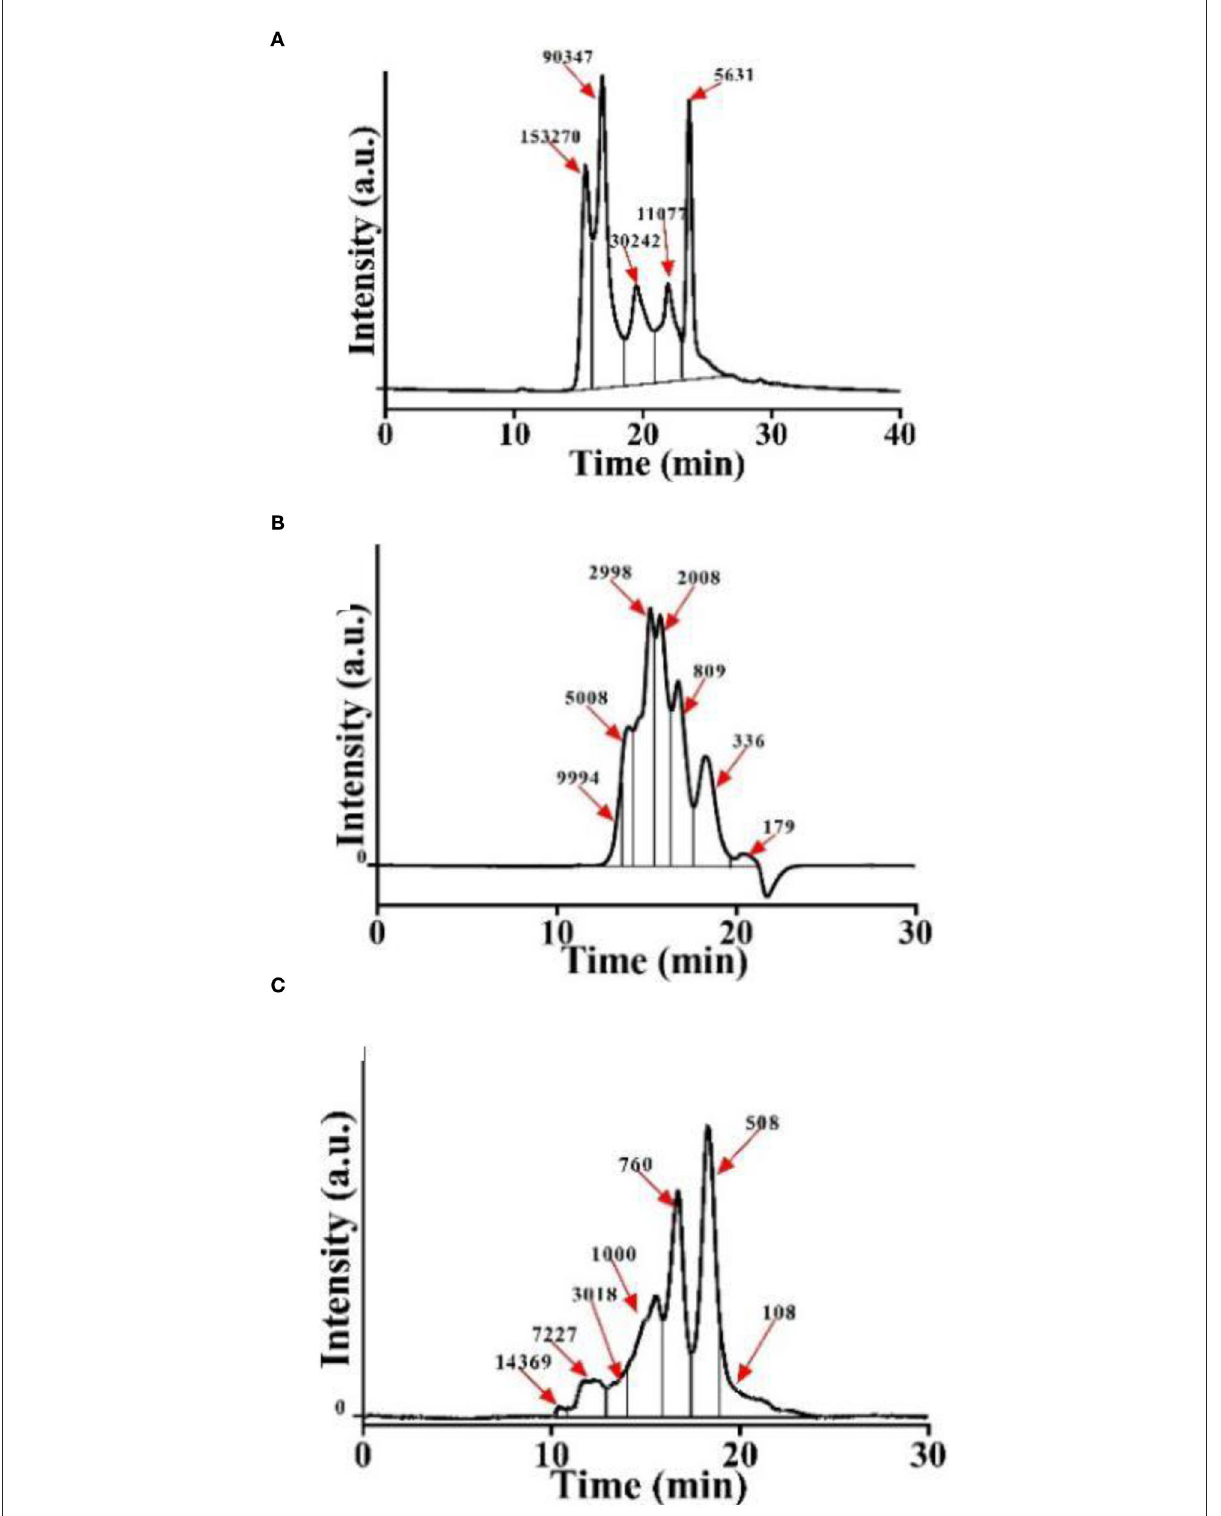
FIGURE1 Molecular weight distribution of CSP . (A) P-1: hydrolyzed by Alcalase–trypsin for 0min. (B) P-2: hydrolyzed by Alcalase–trypsin for 10min. (C) P-3: hydrolyzed by Alcalase–trypsin for 120min.